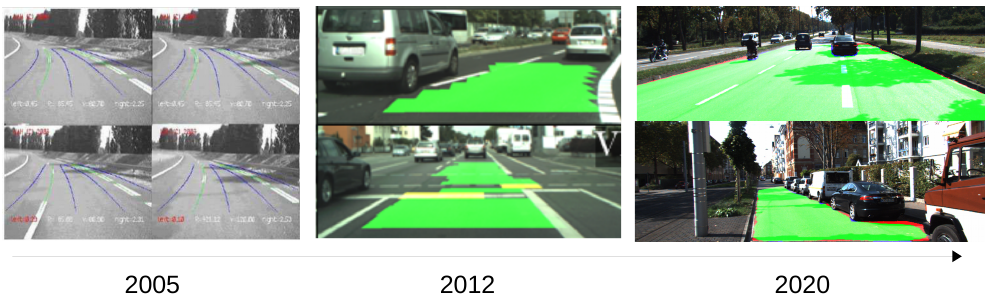
Figure 1. Evolution of pedestrian detection for intelligent vehicles with three examples from [1–3].